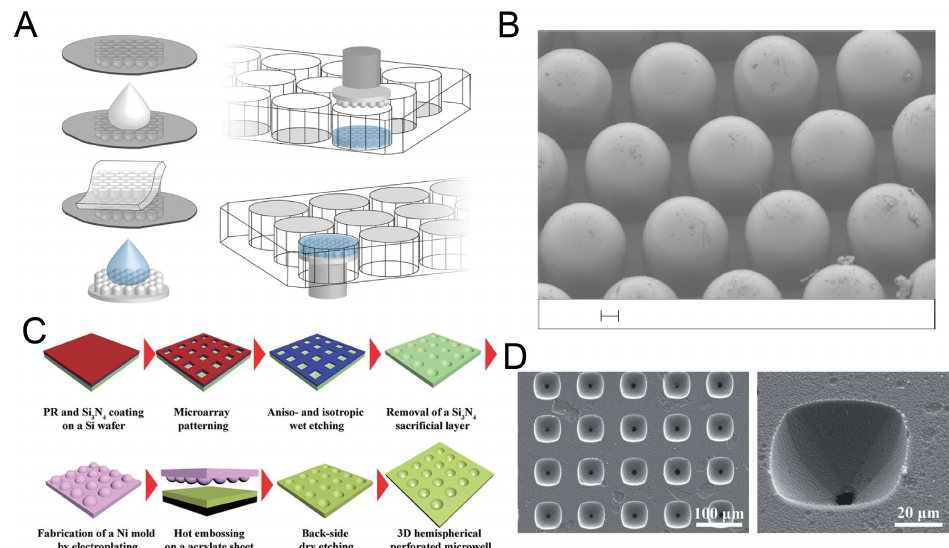
Figure 3. Dry etching and wet etching for the fabrication of concave microwells. ( A ) Fabrication of concave microwells on hydrogel using a silicon mold [41]. First, a silicon mold with concave microwells was used for PDMS casting. Then, the PDMS piece was used as a stamp for molding hydrogel to make concave microwells on hydrogel. ( B ) An SEM picture of the PDMS stamp. Scale bar: 100 µm. Reprinted (adapted) from [41]. Copyright (2020) with permission from Springer Nature. ( C ) The procedures of an array of perforated concave microwells using dry etching and wet etching [42]. ( D ) The SEM pictures of concave microwells using the method illustrated in ( C ) [42]. Reprinted (adapted) from [42]. Copyright (2014) with permission from Royal Society of